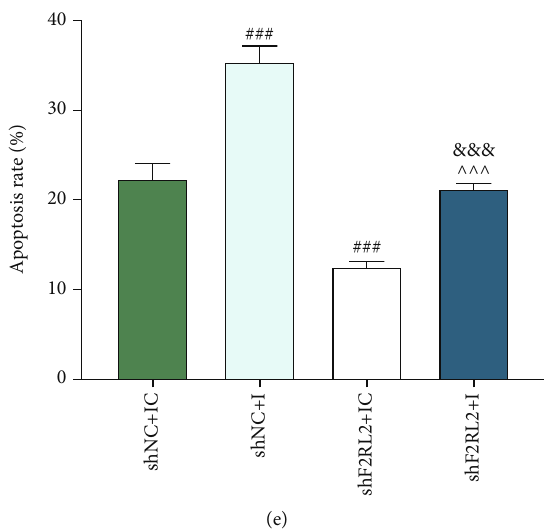
Figure 7: miR-582-5p inhibitor suppressed the viability and enhanced the apoptosis of OGD-induced HCMs by upregulating F2RL2 expression. (a, b) After cells received transfection and OGD induction, the expressions of F2RL2 (a) and miR-582-5p (b) in HCMs were evaluated by qRT-PCR. (c) After cells received transfection and OGD induction, the viability of HCMs was measured by CCK-8 assay. (d, e) After cells received transfection and OGD induction, the apoptosis of HCMs was determined by fl ow cytometry. ( # P < 0 : 05 , ## P < 0 : 01 , and ### P < 0 : 001 , vs. shNC+IC; ^^^ P < 0 : 001 , vs. shNC+I; & P < 0 : 05 and &&& P < 0 : 001 , vs. shF2RL2+IC) (HCMs: human cardiac myocytes; F2RL2: coagulation factor II thrombin receptor like 2; OGD: oxygen-glucose